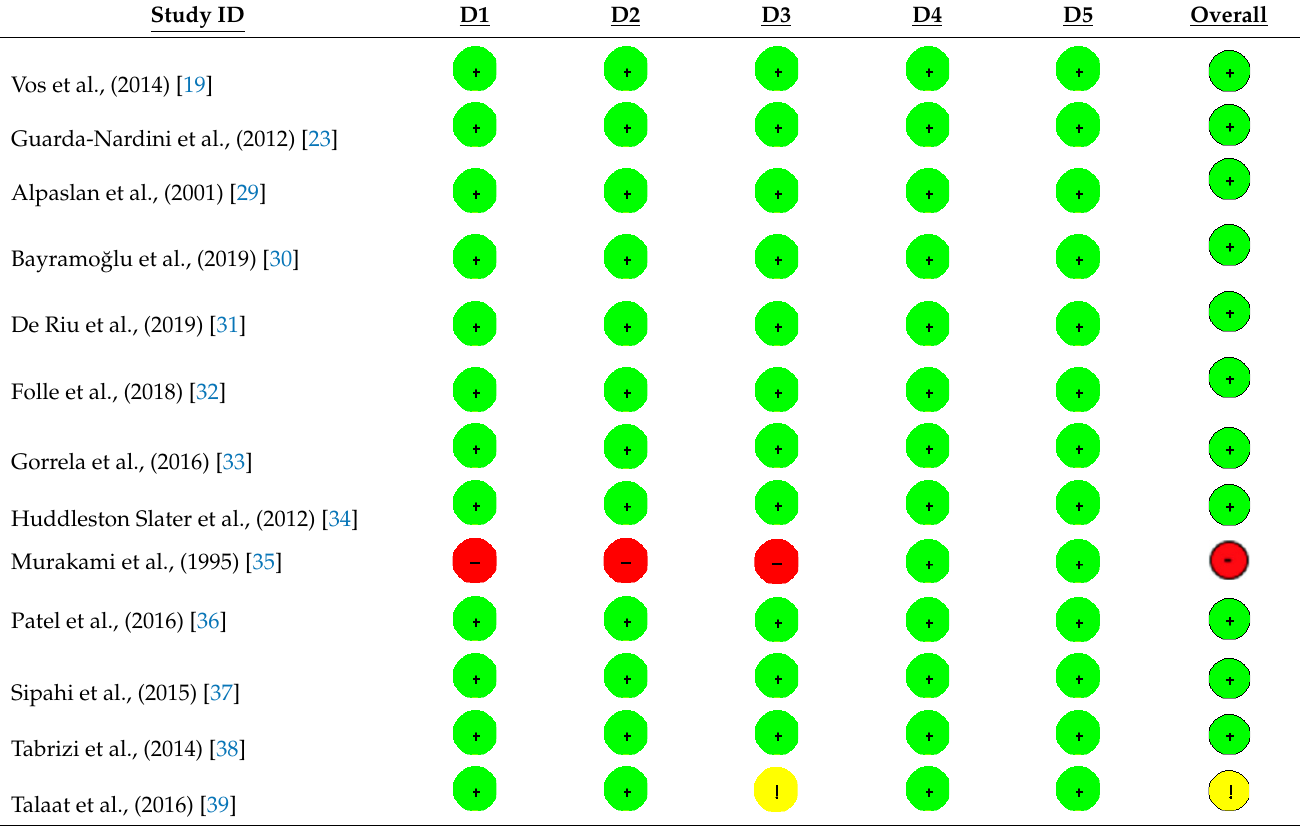
Table 2. Risk of bias assessment .